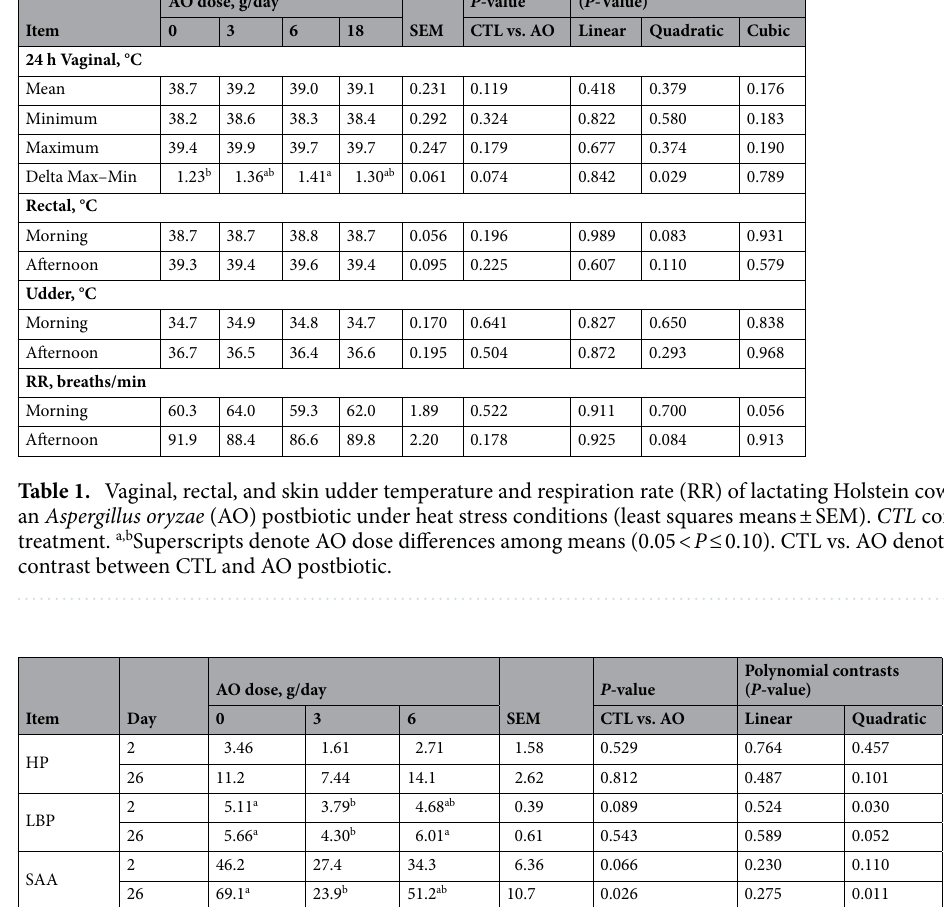
Table 2. Acute-phase protein concentrations (μg/mL) in plasma of lactating heat-stressed cows fed different doses of an Aspergillus oryzae (AO) postbiotic. Data are least squares means (LSM) ± SEM. CTL control treatment, HP haptoglobin, LBP LPS binding protein, SAA serum amyloid A. a,b Superscripts denote AO dose differences among LSM (0.05 < P ≤ 0.10). CTL vs. AO denotes contrast between CTL and AO postbiotic.